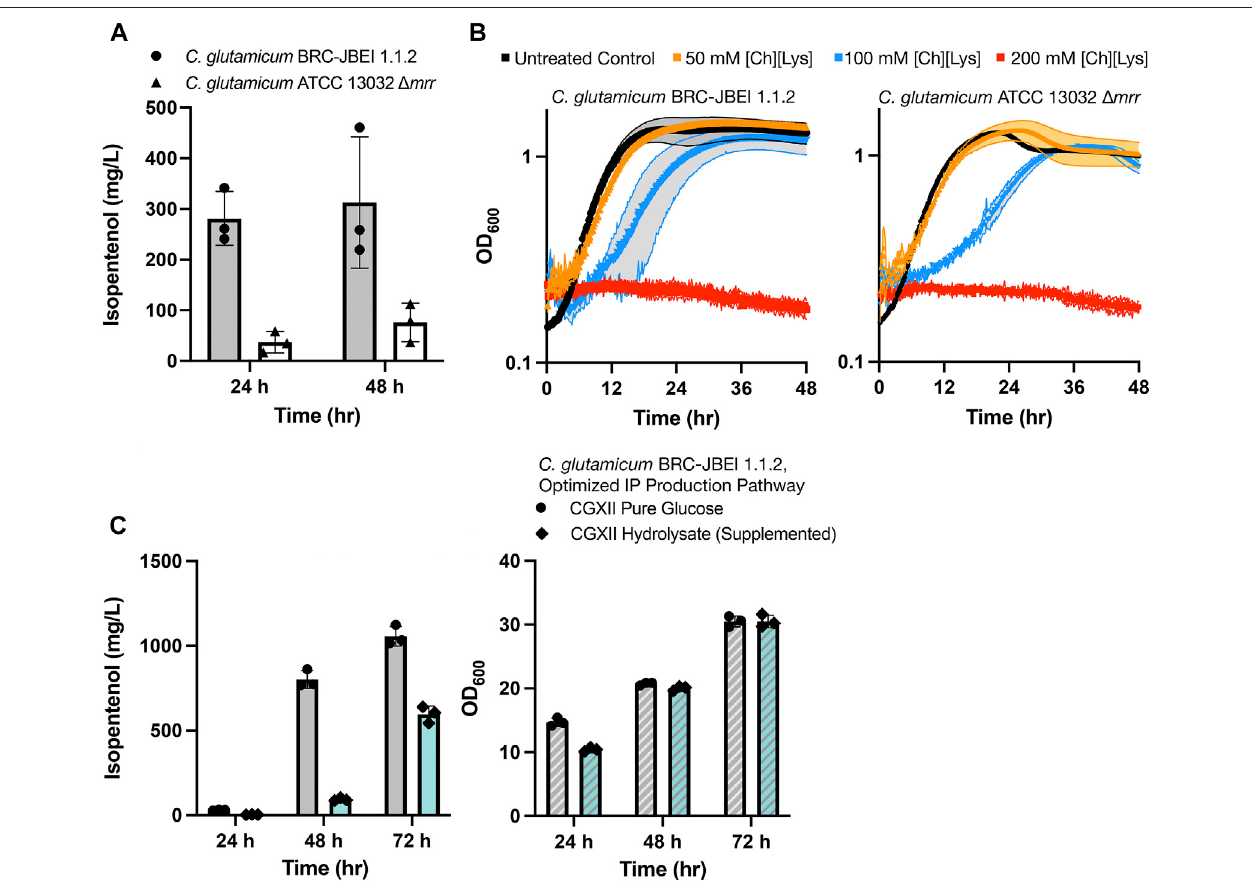
FIGURE 1 | Growth and isopentenol production characterization of two genetically distinct engineered C. glutamicum strains, (A) Isopentenol (IP) production in C. glutamicum strainsofthegenotypesindicatedharboring anIPproductionplasmid. Cellswerecultivatedin24-welldeep wellplates.IPtitersreportedat48-htimepoints are corrected for evaporation in this plate format (Materials and Methods), (B) Growth curves for C. glutamicum strains of the indicated strain backgrounds cultivated in CGXIImediainthepresenceorabsenceoftheIL,choliniumlysinate([Ch][Lys]),[Ch][Lys]wasexogenouslyaddedtotheculturemediaatthestartofthetimecourse, (C) Production of IP from C. glutamium grown in CGXII minimal media with pure glucose (4% w/v) or ensiled [Ch][Lys] pretreated sorghum hydrolysate. An optimized IP production plasmid carrying a hmgR variant from Silicibacter pomeroyi was used. The optical density of cultures as a proxy for cell density is noted on the right-hand